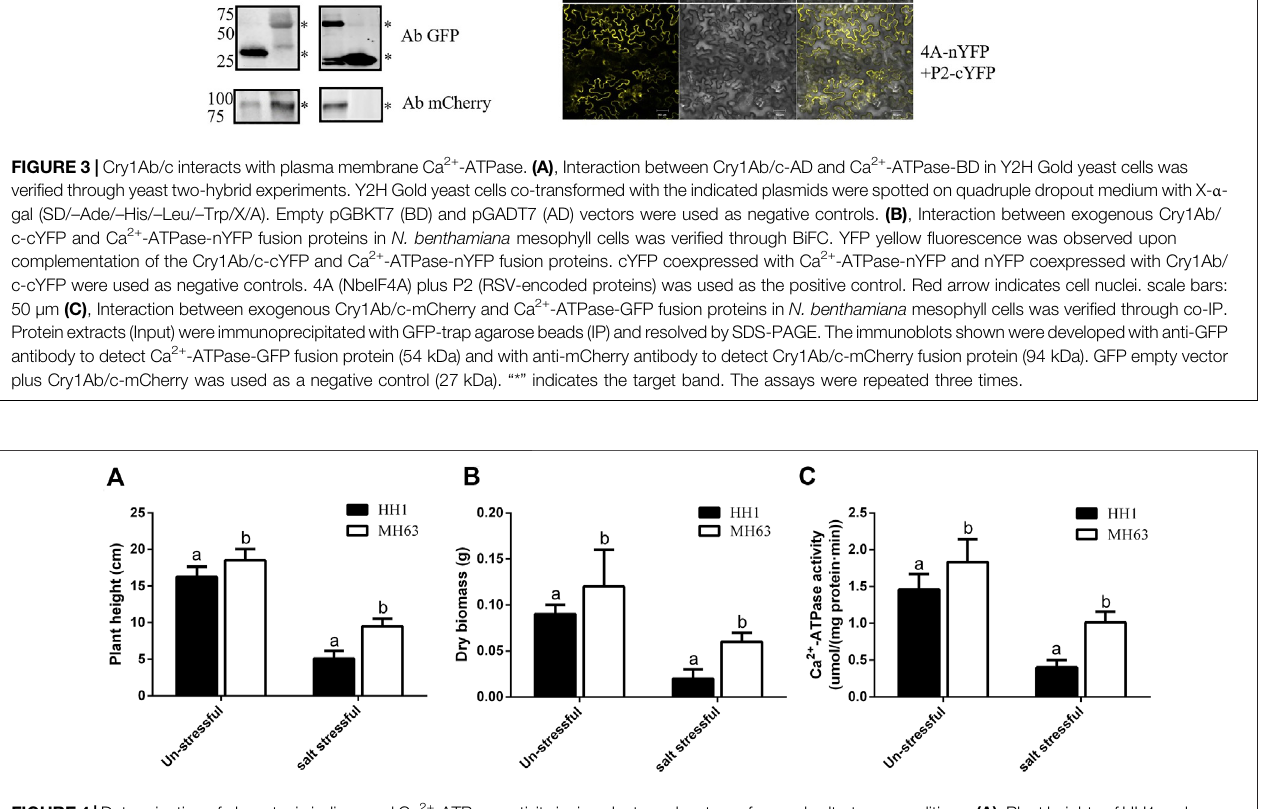
FIGURE4| Determination ofphenotypicindicesand Ca 2+ -ATPaseactivity inriceplants under stress-free and salt-stress conditions. (A) ,Plant heights ofHH1 and MH63 rice plants under stress-free and salt-stress conditions. (B) , Dry biomass of HH1 and MH63 rice plants under stress-free and salt-stress conditions. (C) , Ca 2+ - ATPaseactivityinHH1andMH63riceplantsunderstress-freeandsalt-stressconditions.Lowercaselettersindicatesigni fi cantdifferencesamongtreatmentmeans( p ≤ 0.05; Student ’ s t